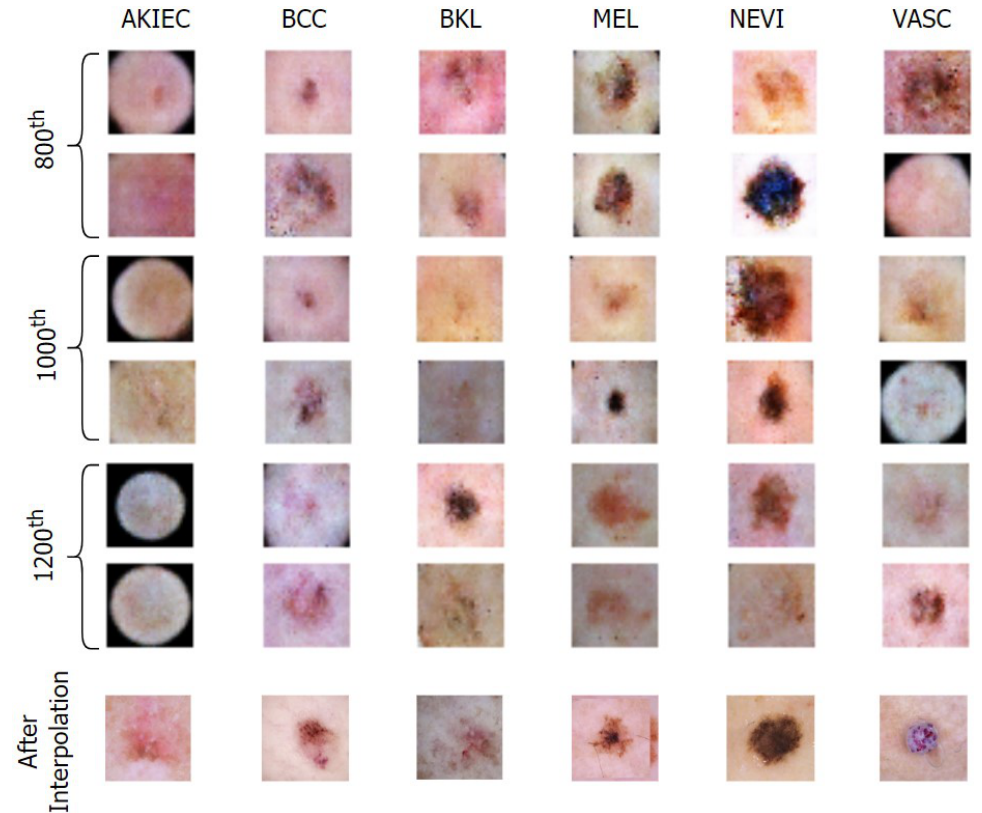
Figure 9. Generation of conditional skin lesions in each category at the final